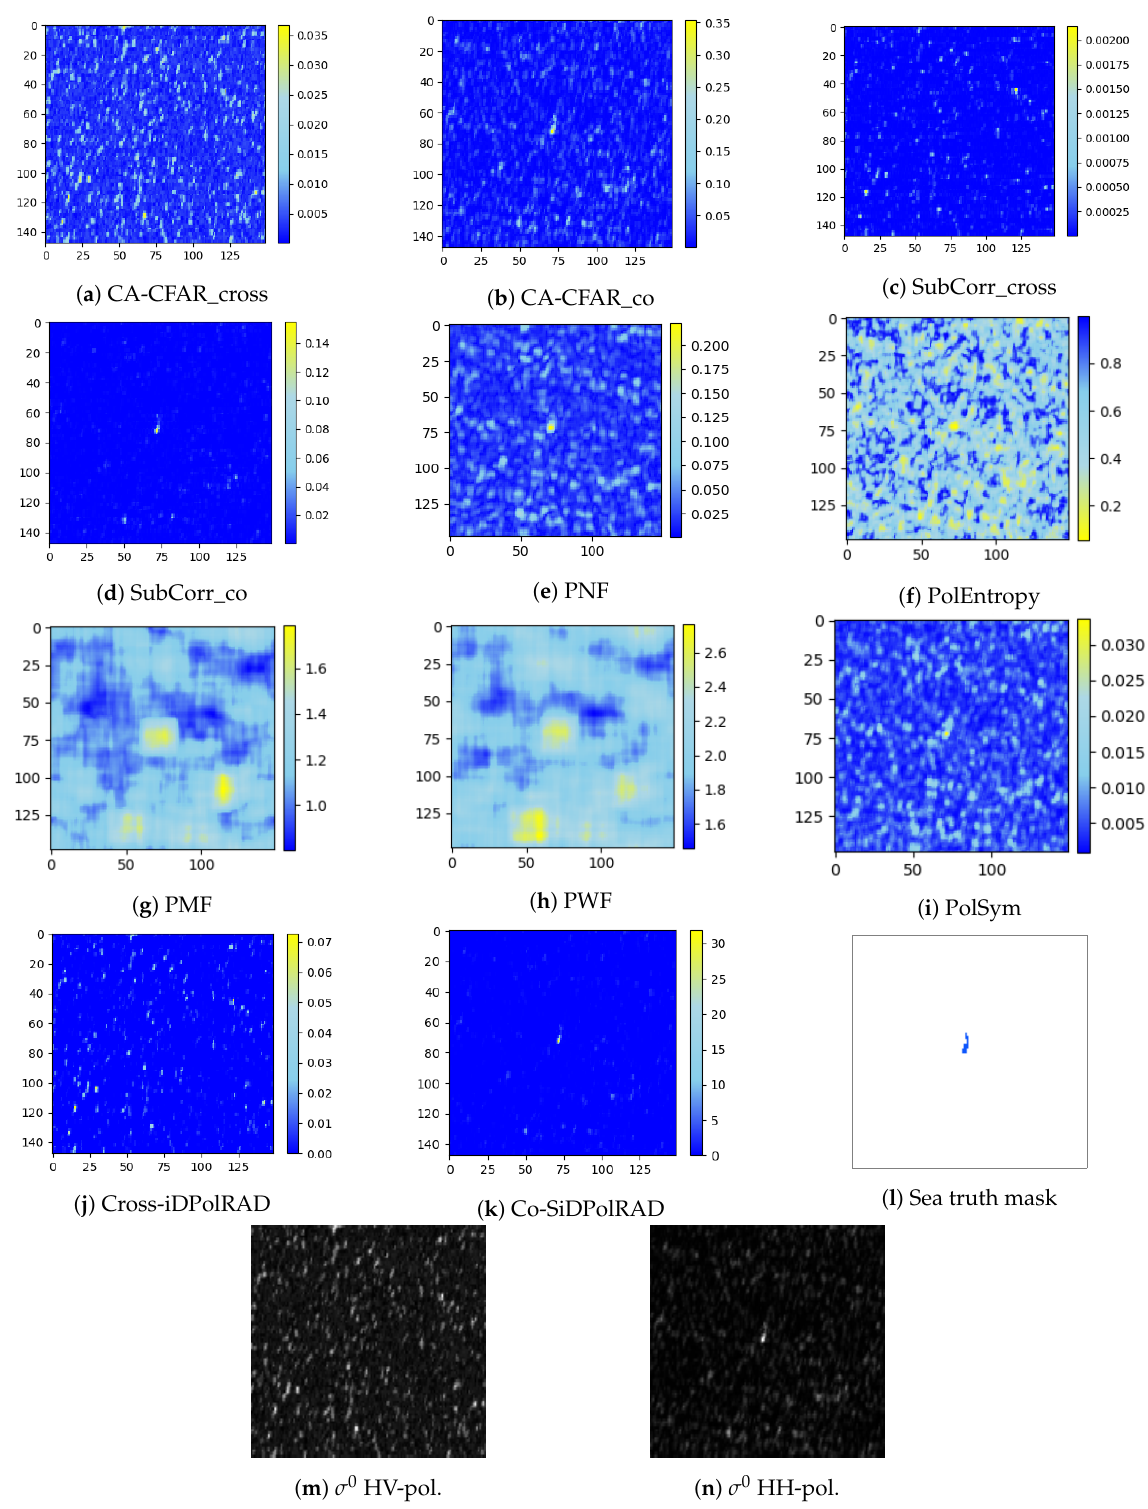
Figure 6. Incidence angle: low; boat: orthogonal, non-moving; polarization: low; mode: SM; dual-pol HV and HH (scale in meters, colour ramps are without